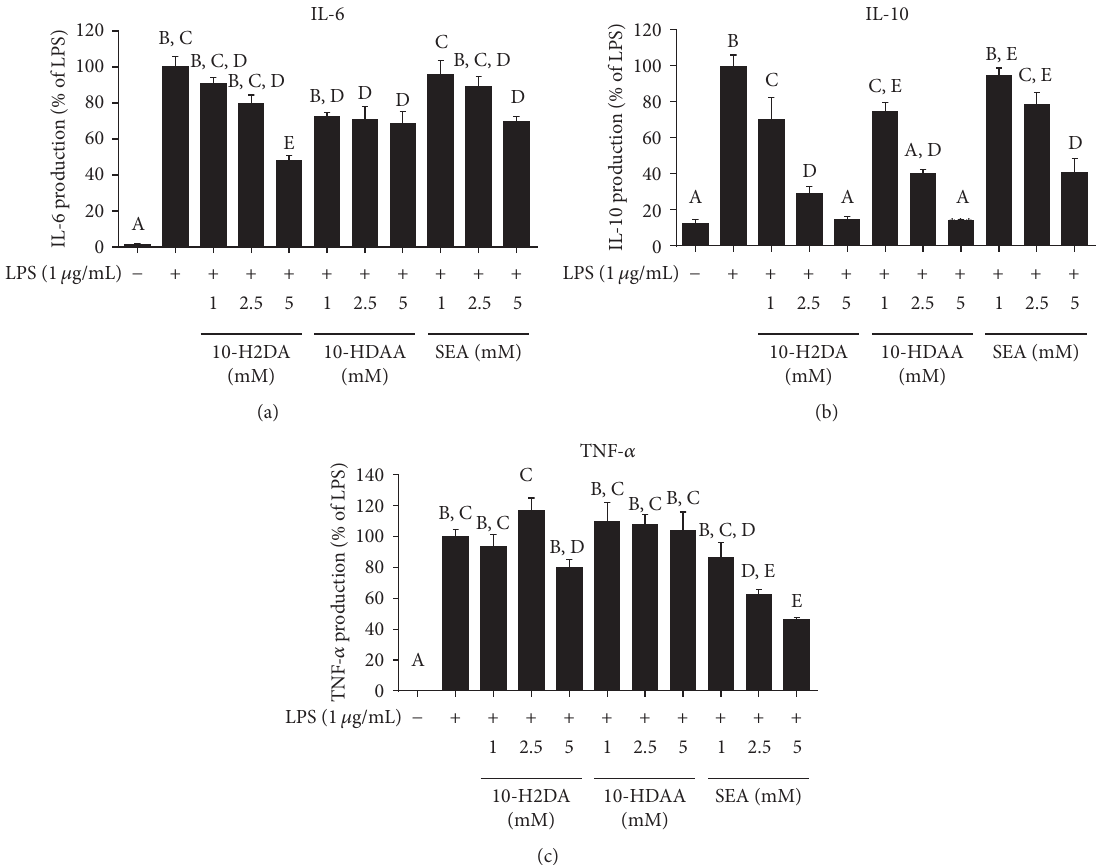
Figure 4: Effects of 10-H2DA, 10-HDAA, and SEA on LPS-induced IL-6, IL-10, and TNF- 𝛼 production in RAW 264.7 cells. Cells were pretreated with/without indicated concentrations of 10-H2DA, 10-HDAA, or SEA for 1h and then stimulated with LPS (1 𝜇 g/mL) for 24 h. Control values were obtained in the absence of LPS or the treatment. The values are presented as percentages of IL-6 (a), IL-10 (b), and TNF- 𝛼 (c) in comparison with LPS-treated cells, respectively. The data are the means ± SEMs for three independent experiments. One- way ANOVA with the Student–Newman–Keuls method was performed to compare all groups; means with different letters are significantly different ( 𝑃 < 0.05